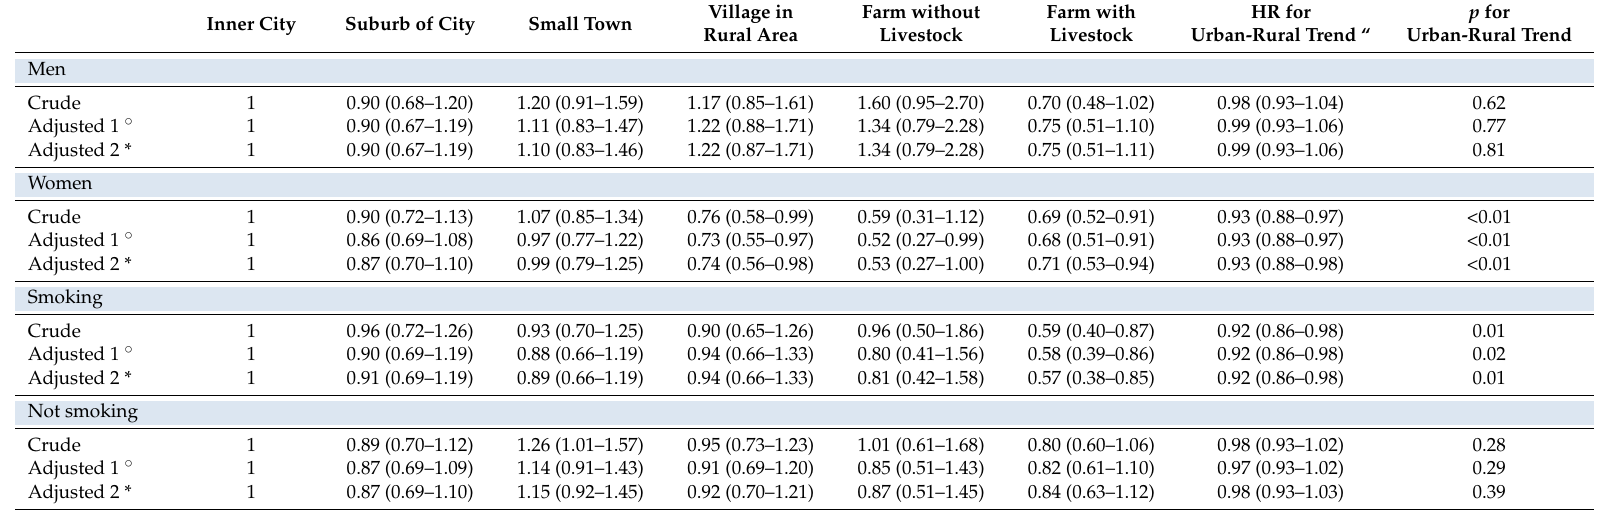
Table 3. Cox regression analyses on asthma stratified by sex and smoking status presented as HR (95% CI). Inner